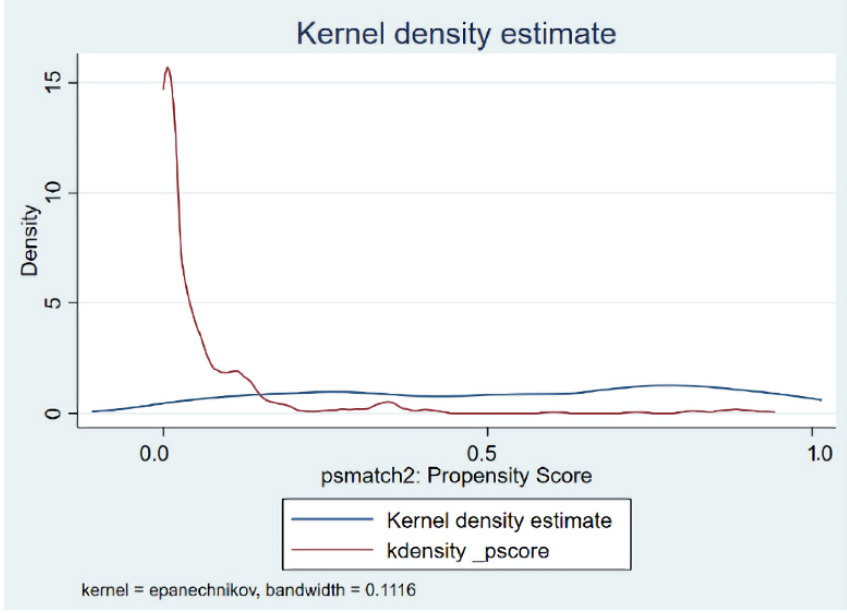
Figure 3. Probability density after matching.